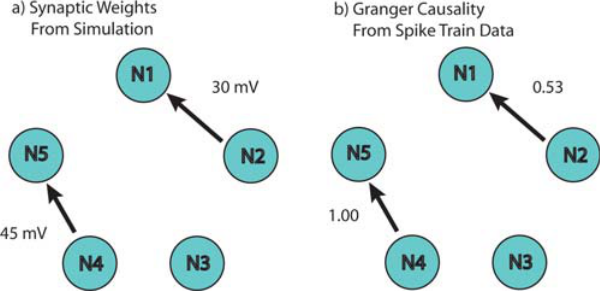
Figure 3. Topology of a Simple Five-Neuron Network Using Pairwise Granger causality. In panel a) the synaptic weights from N1 to N2 and N4 to N5 have been synaptically coupled. N3 is left uncoupled to demonstrate that a pairwise GC will indicate null connectivity. Equivalent but independent random processes drive each of the five neurons. 100 realizations of this network using Izhikevich’s simple neuron model with these weights yields the results shown in panel b) using pairwise Granger causality. These results demonstrate that pairwise Granger causality can not only resolve the difference between null and actual connectivity, but also determine the directionality of those influences.